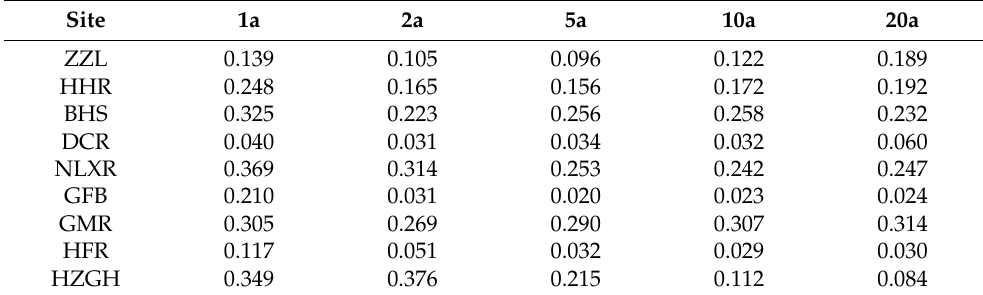
Table 14. Changes of maximum waterlogging depth under RCP8.5 compared with RF period (unit: m).